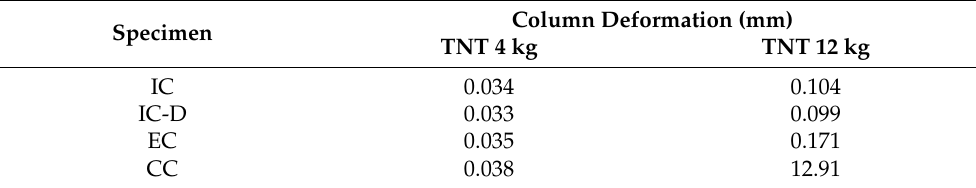
Table 6. Maximum horizontal deformation of the